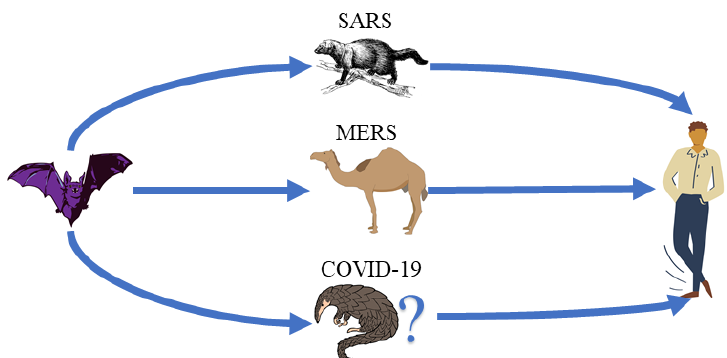
Figure 1. Simplified transmission scheme with likely